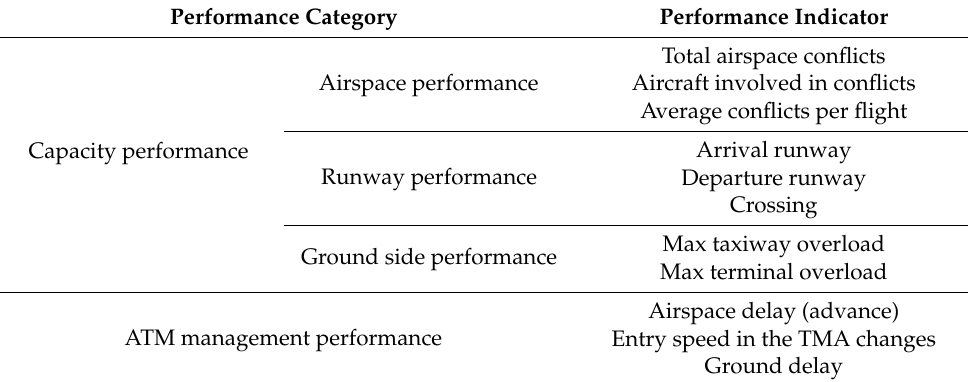
Table 6. Performance